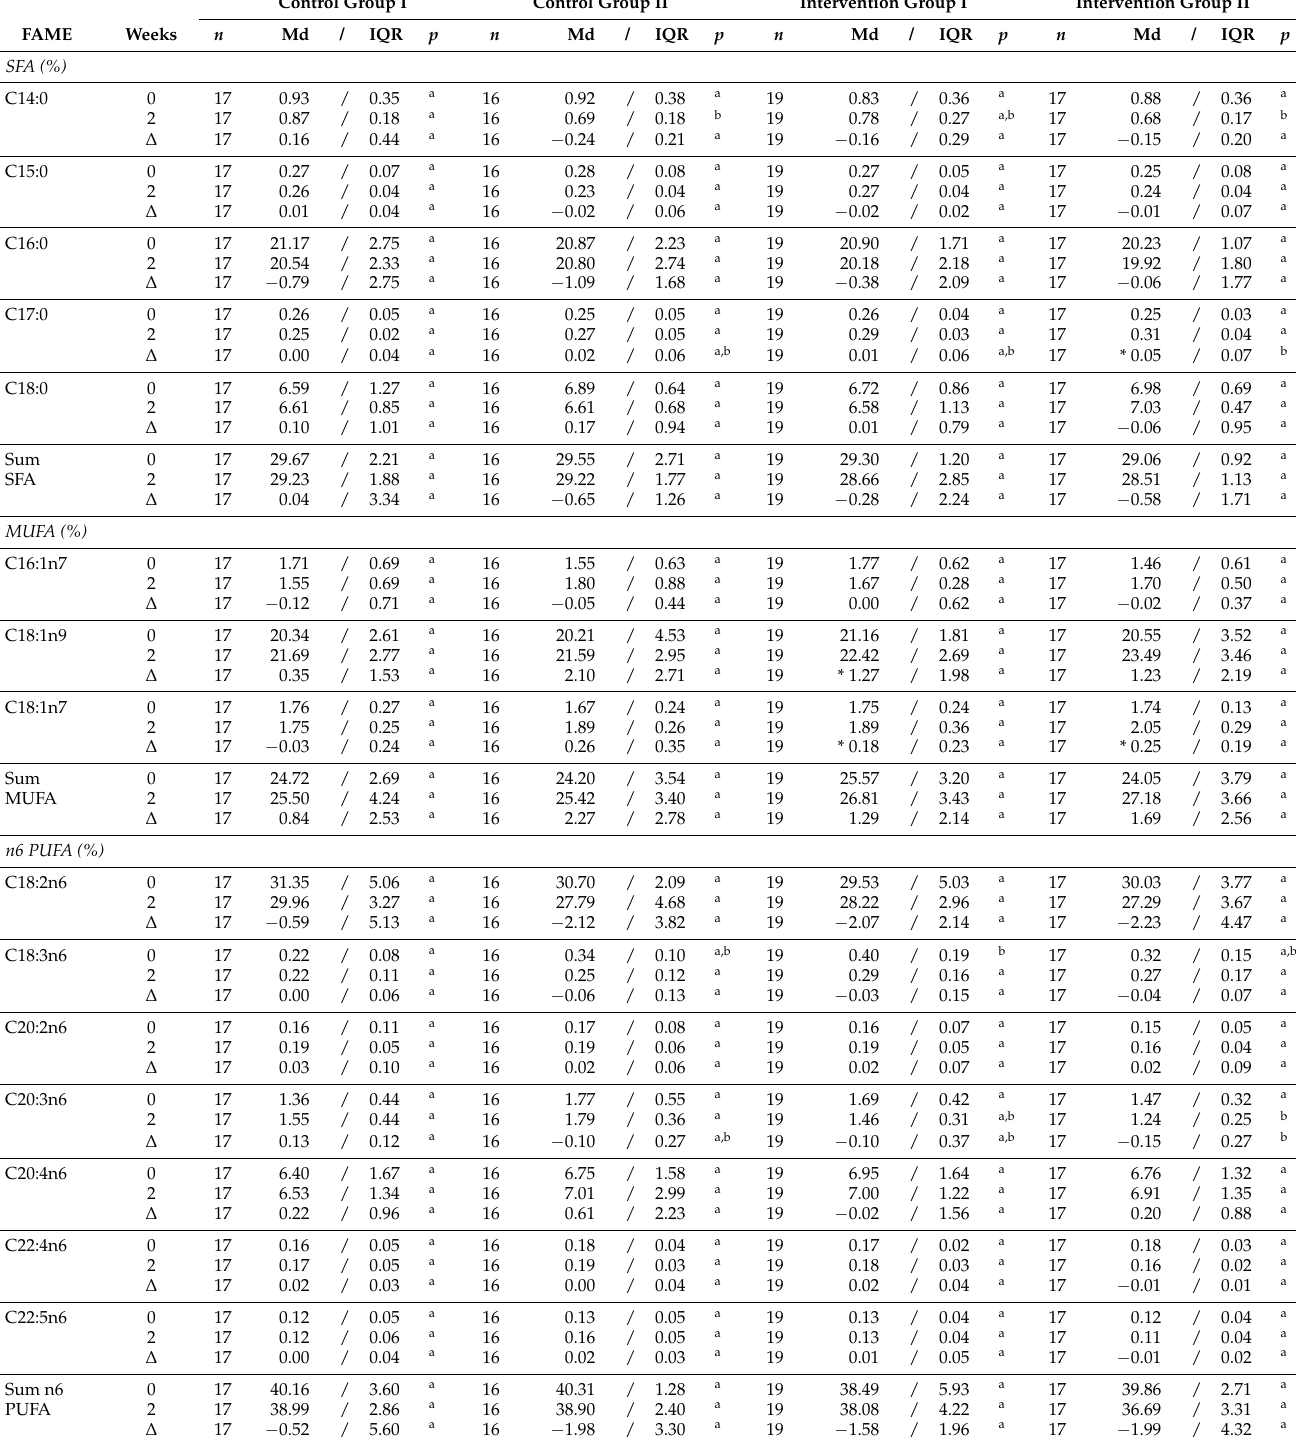
Table 4. Fatty acid profile in plasma lipids of the NovAL study participants ( n =